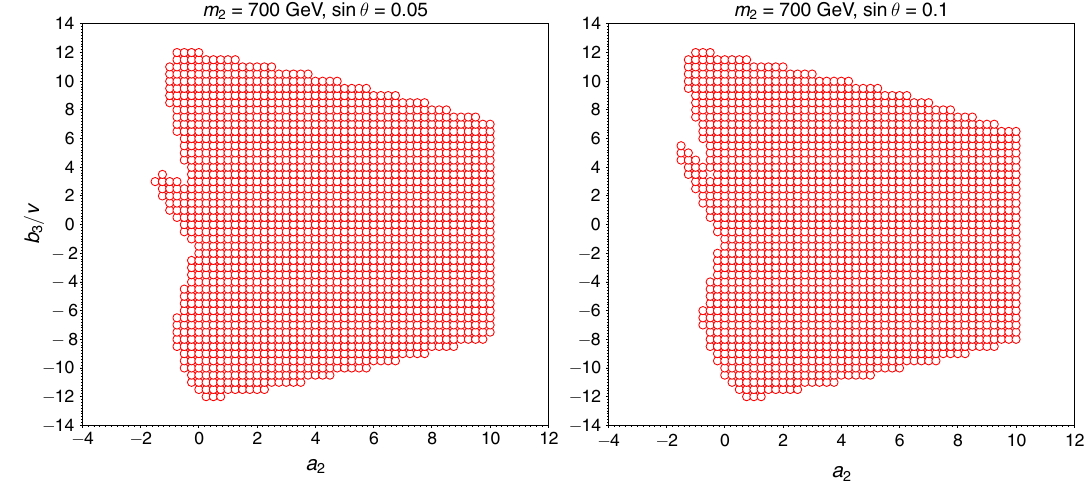
Fig. 12 Same as Fig. 10, but for m 2 = 700